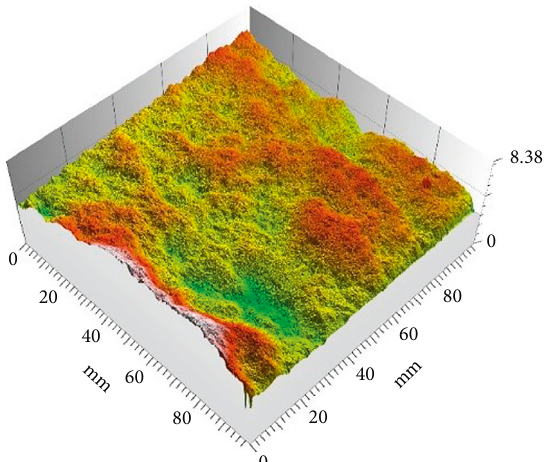
Figure 10: Normalized JRC change curves under heat-wet cycles and repeated shear. Table 2: JRC under heat-wet cycles.